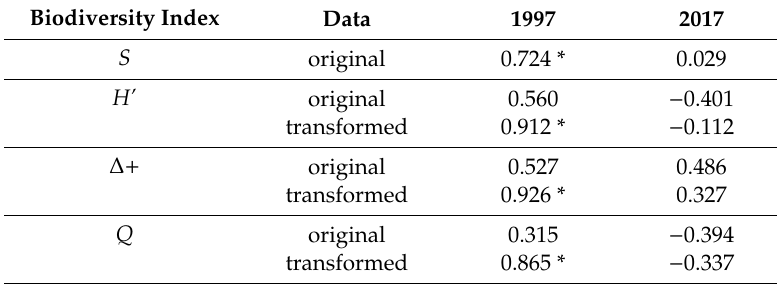
Table 8. Relationship between weed biomass and weed biodiversity (original or transformed data respectively) showed in simple correlation coe ffi